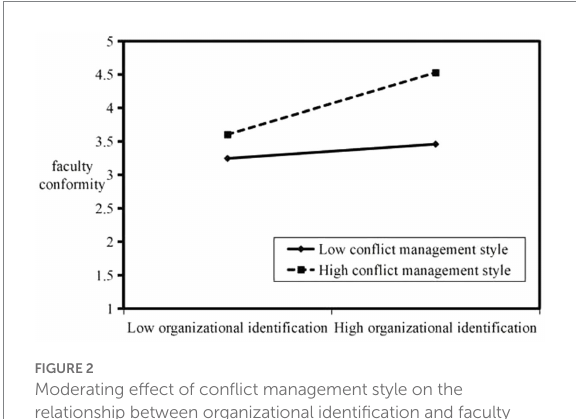
FIGURE 2 Moderating effect of conflict management style on the relationship between organizational identification and faculty conformity. FIGURE 3